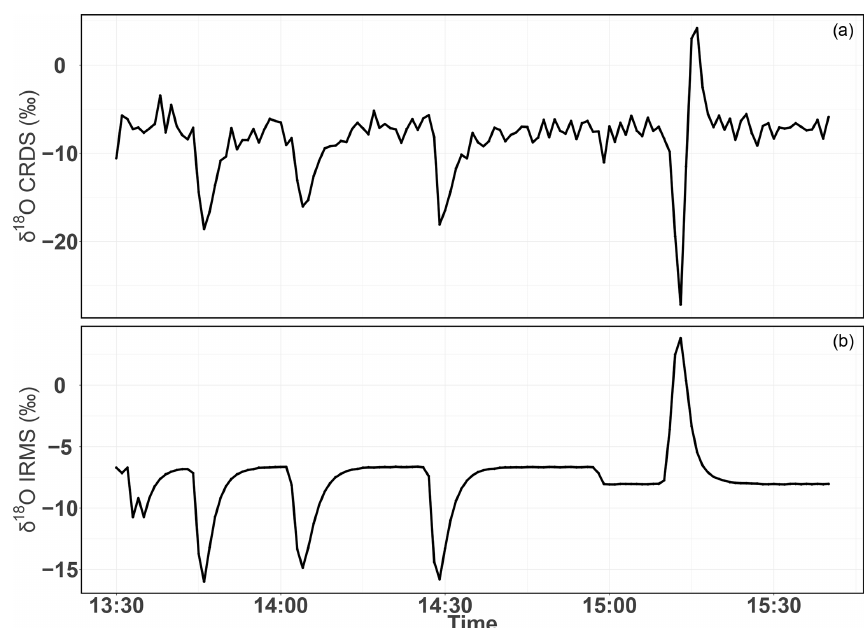
Figure 18. Consecutive δ 18 O measurements of a standard gas (CO 2 -free air) filled into three flasks followed by measurement of breath air using the CRDS analyzer (a) and the IRMS (b) . These measurements were carried out in the middle of ambient air